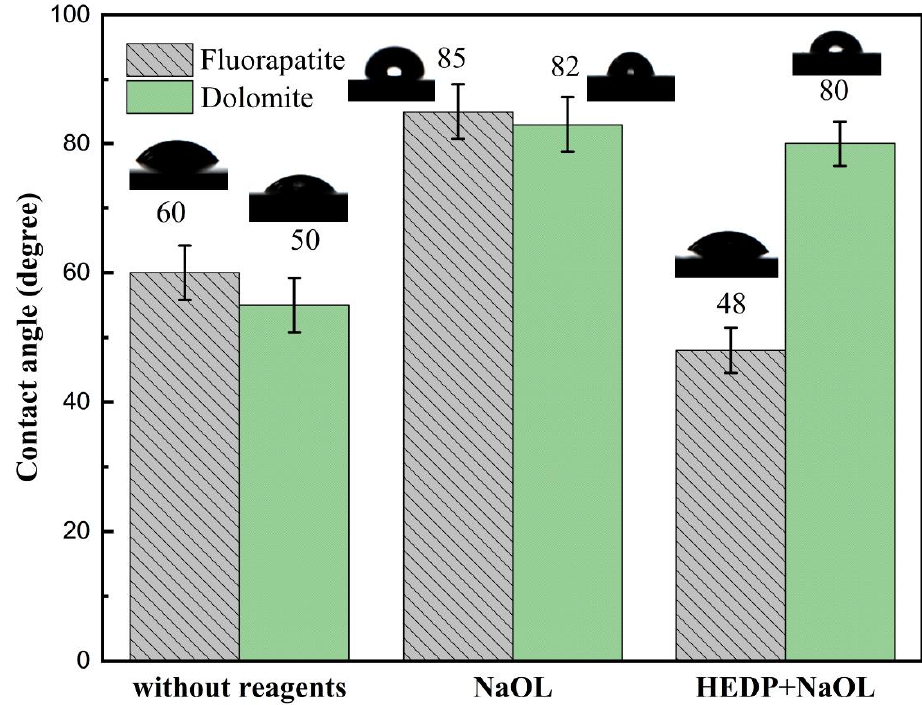
Figure 7. Contact angles of fluorapatite and dolomite under the reaction of HEDP and NaOL (HEDP: 3 × 10 − 5 mol/L; NaOL: 5 × 10 − 4 mol/L; pH = 6.0).